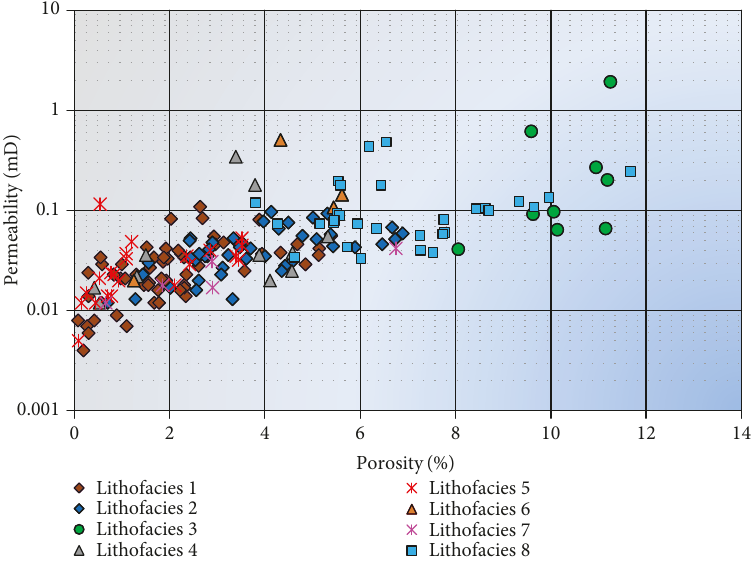
Figure 8: Cross-plot of permeability and porosity for various densi fi cation lithofacies within the studied